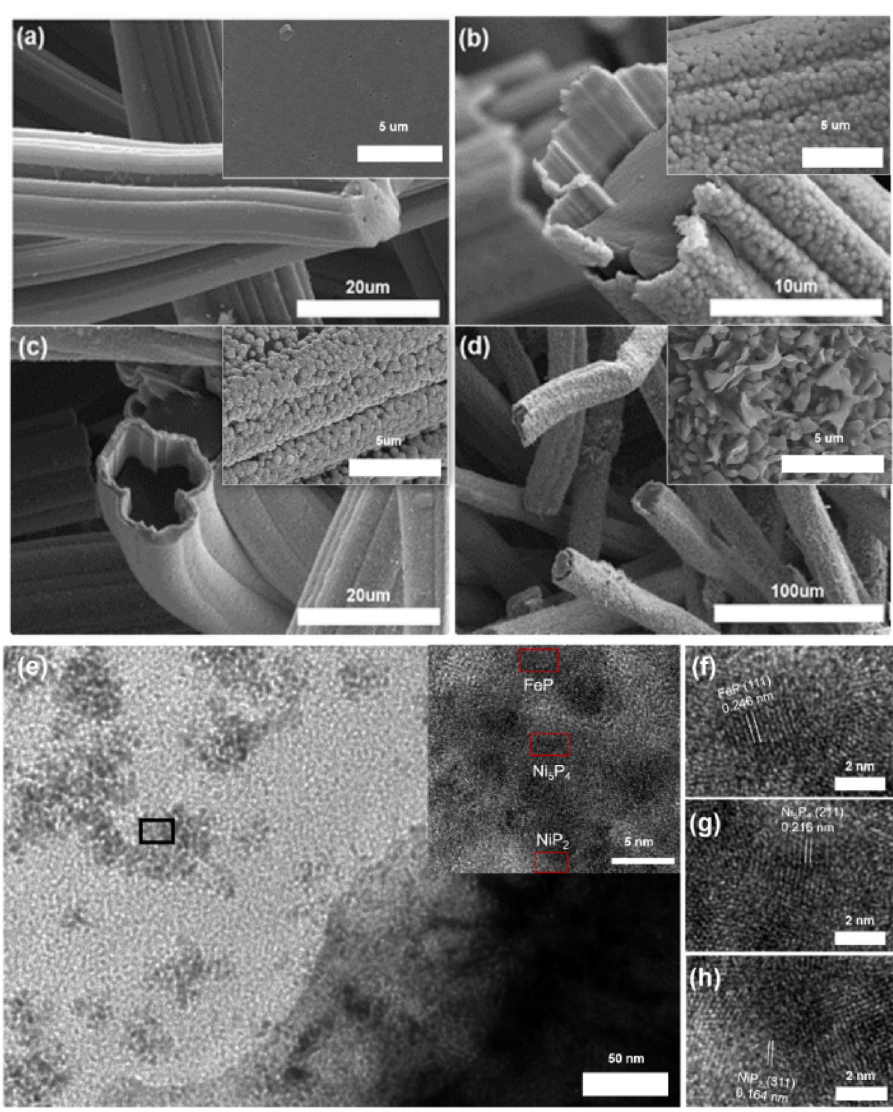
Figure 2. SEM micrographs of ( a ) CF, ( b ) Ni@CF, ( c ) Ni–Fe@CF, and ( d ) P-NiFe@CF with corresponding magnified images; and ( e – h ) HRTEM images of